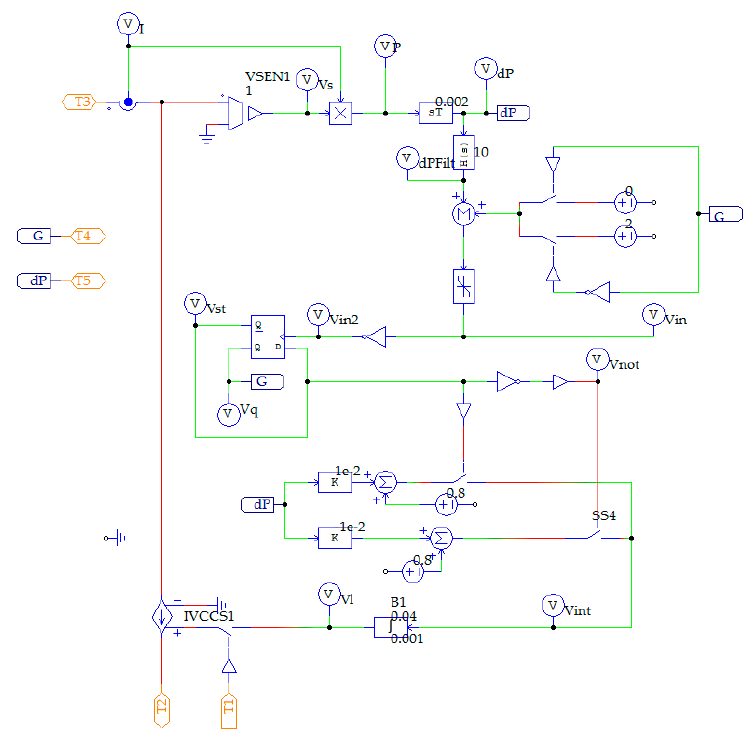
Figure 6. The PSIM circuit for MPPT control.